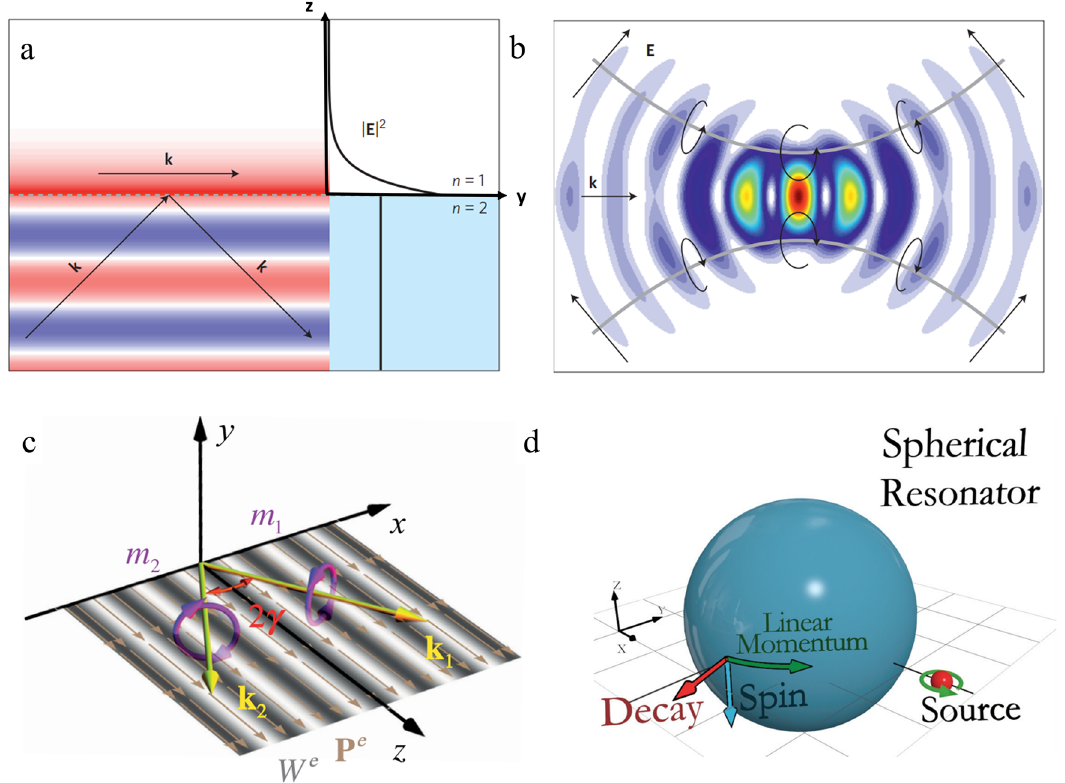
Figure 3: Identifying the transverse spin using the “ k -method ” in various optical con fi gurations: (a) single polarized evanescent wave [50]; (b) focused single polarized Gaussian beam [22]; (c) two-waves interference fi eld [58, 59], and (d) whispering-gallery-mode in optical resonators